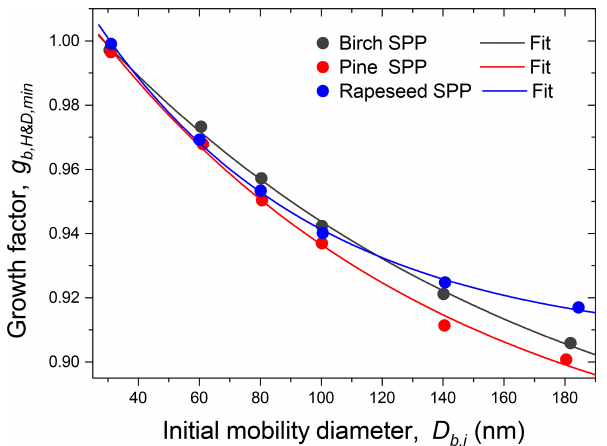
Figure 4. Minimum mobility growth factors ( g b, H&dD , min ) of birch, pine, and rapeseed subpollen particles as a function of initial mobility diameter ( D b,i ). The lines are the exponential fit functions with the best-fitting parameters listed in Table